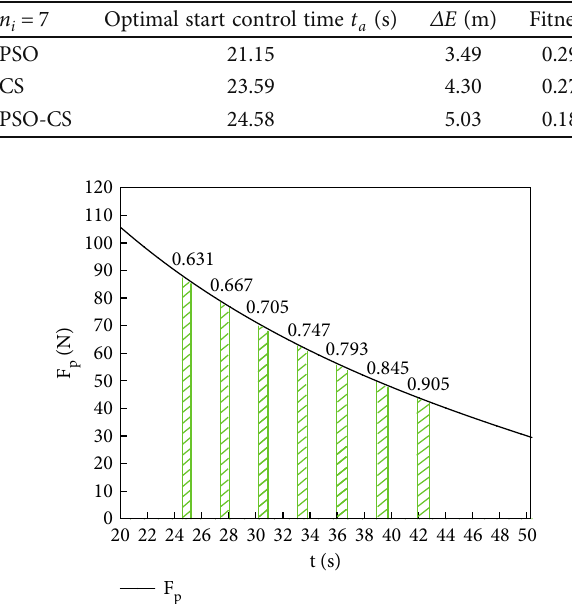
Figure 10: A schematic diagram of projectile optimal correction working parameters.